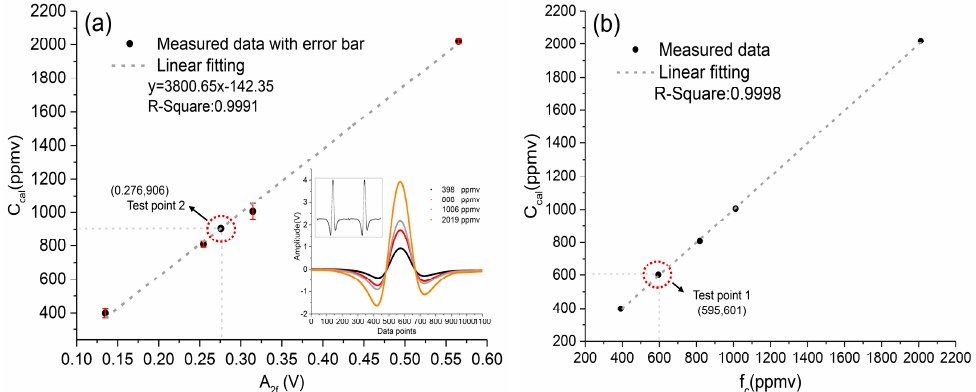
Figure 3. The measured 2f-signal versus corresponding concentrations of calibration gases. ( a ) System calibration experiment with four calibration gases. C cal : concentration of calibration gases. ( b ) Verification results of the system calibration model. fc: gas-phase concentration; Test point 1: another standard gas of 601 ppmv used as a checkpoint.